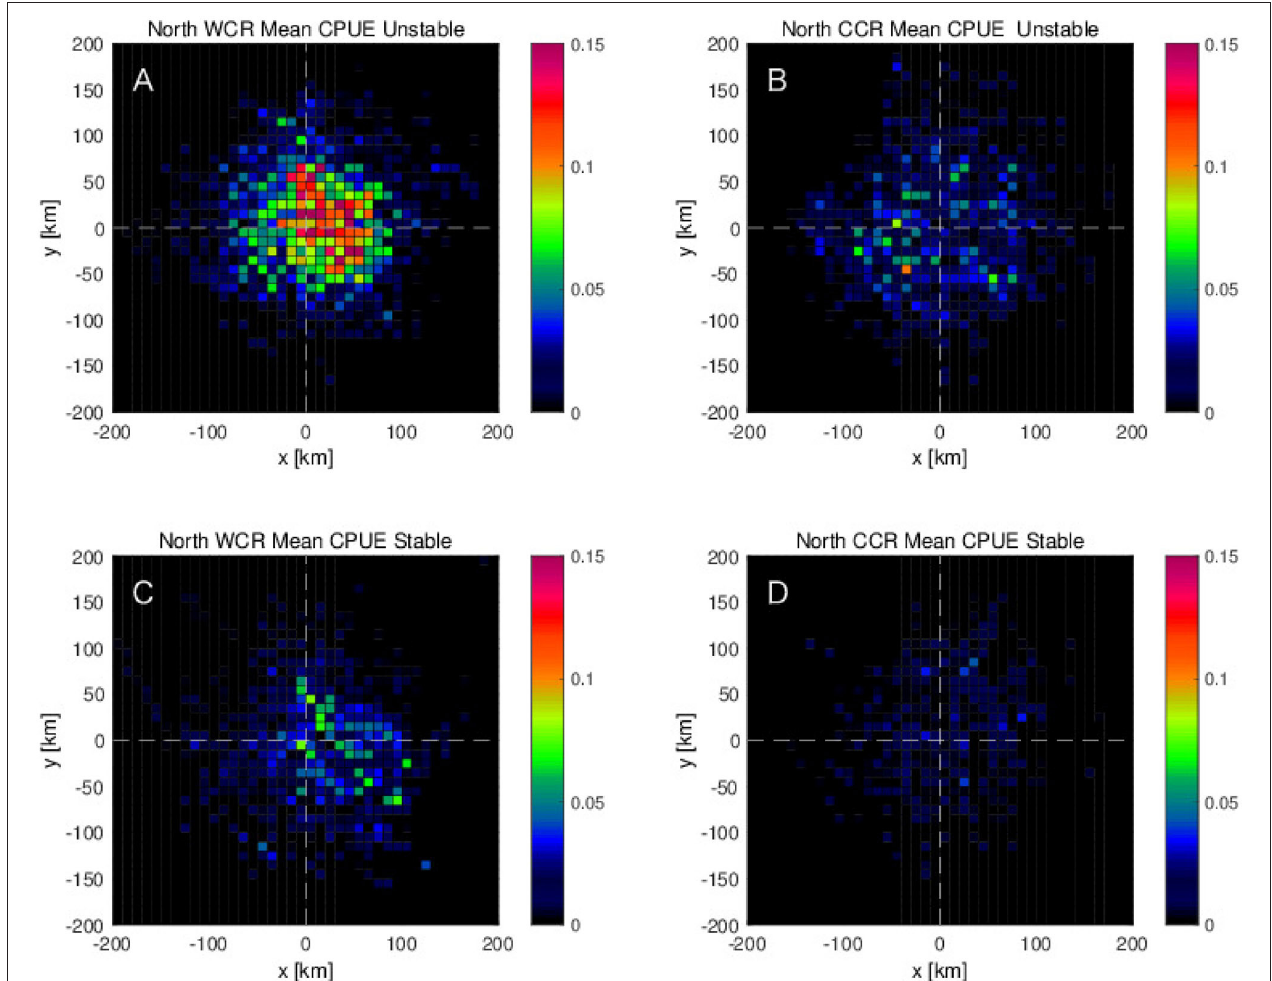
FIGURE 10 | Mean CPUE for the northern region, 140–175 ◦ E and 36–45 ◦ N as a function of distances from the center of eddies along zonal and meridional directions for (A,C) anticyclonic eddies (or warm-core rings: WCR) and (B,D) cyclonic eddies (or cold-core rings: CCR), which are closest to each swordfish fishing position in (A,B) unstable period 2006–2009 and in (C,D) stable period for years 2004, 2005, and 2010.